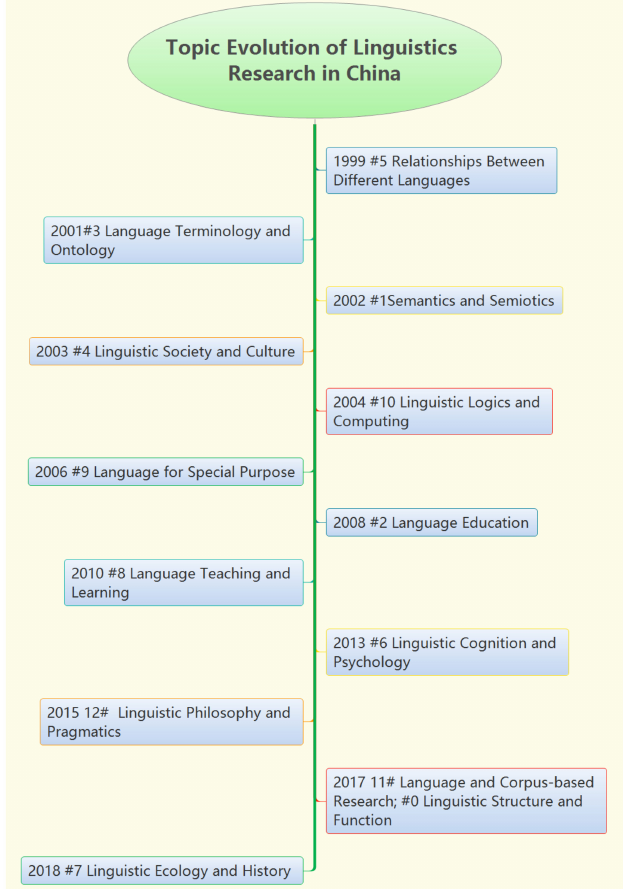
Figure 10. The topic evolution of linguistics research in